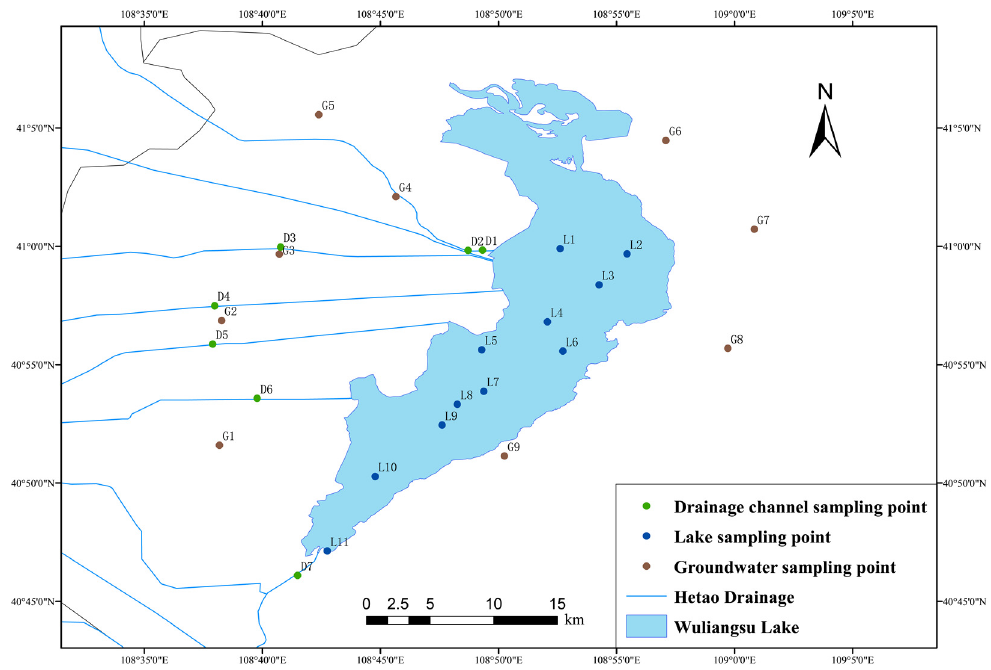
Figure 1. Distribution of the sampling sites in the study area.